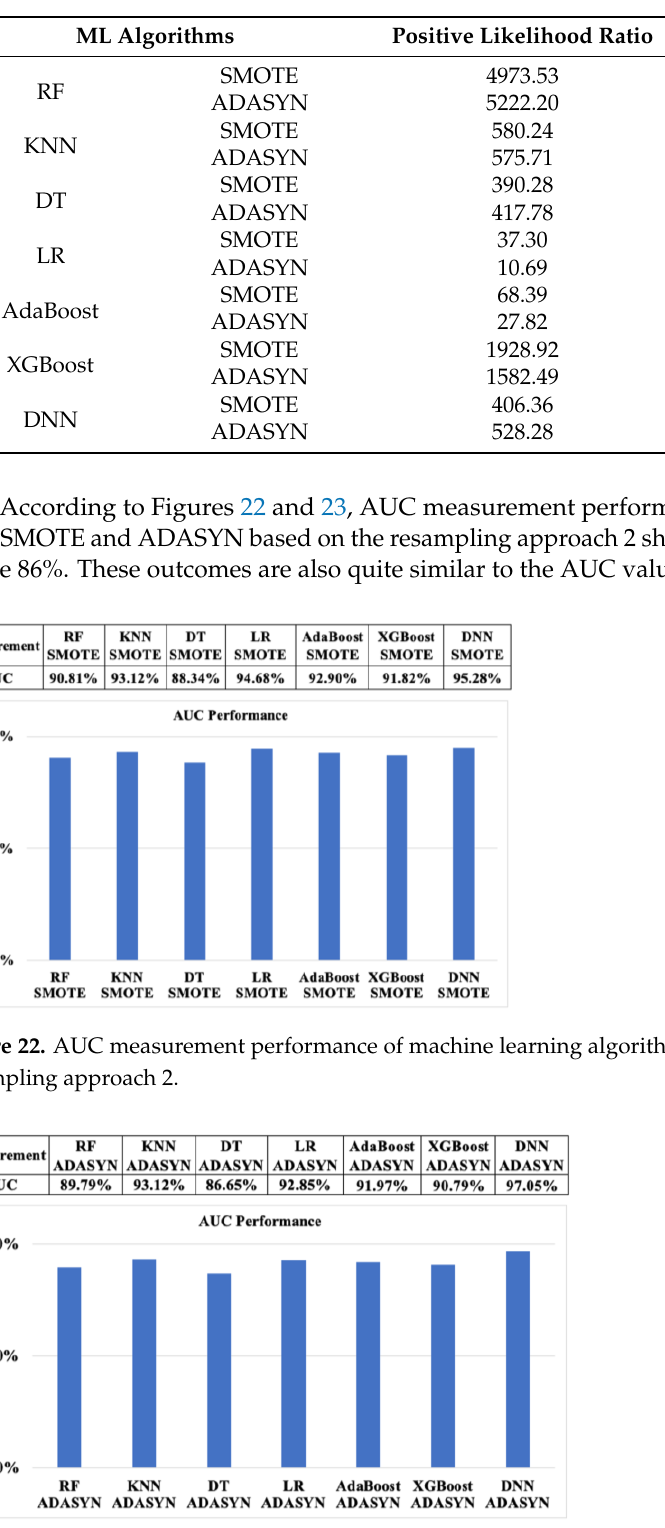
Figure 23. AUC measurement performance of machine learning algorithms with ADASYN based on resampling approach 2.